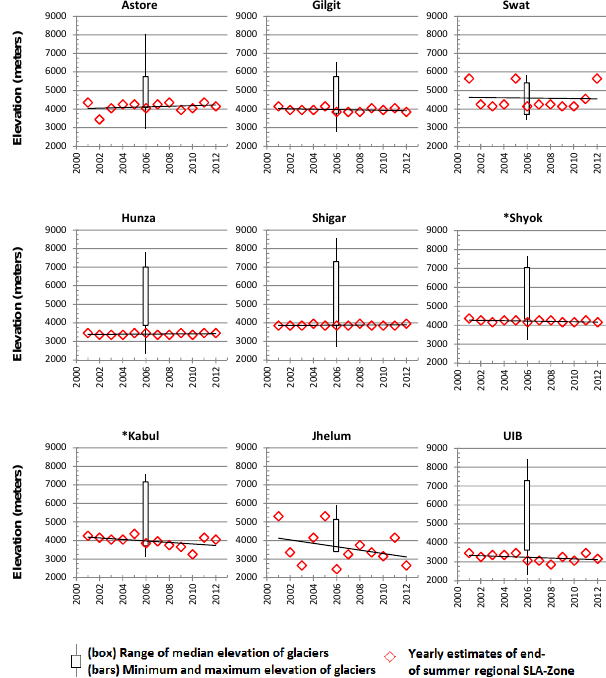
Figure 12. Median elevation of glaciers and inter-annual variabil- ity of the end-of-summer regional SLA zone for each studied basin. Note: basins marked with (*) feature statistically significant trends. The median elevation of glaciers along with the minimum and max- imum elevations shown in the box plot are time